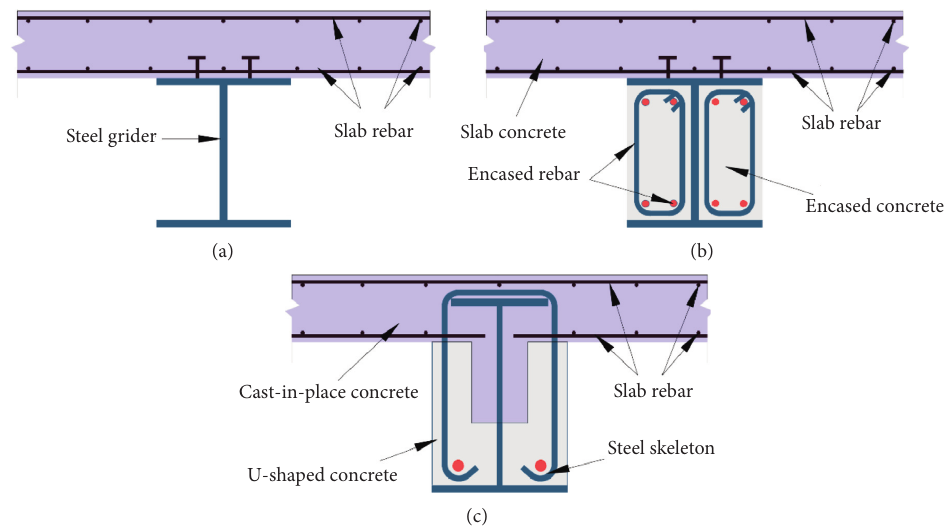
Figure 1: Evolution of the PPECB. (a) SCCB. (b) PECB. (c) PPECB.